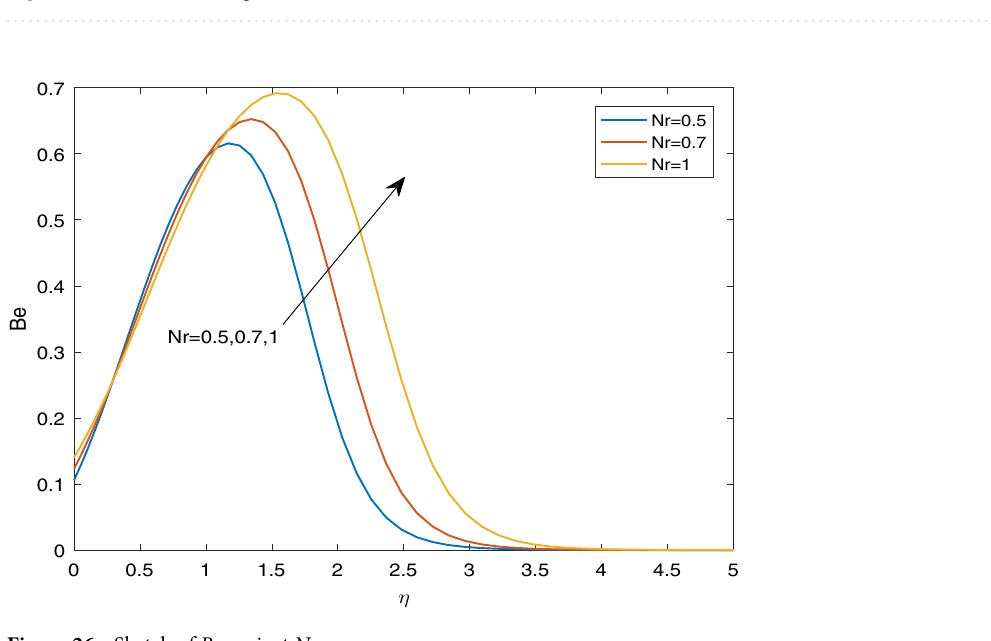
Figure 26. Sketch of Be against Nr